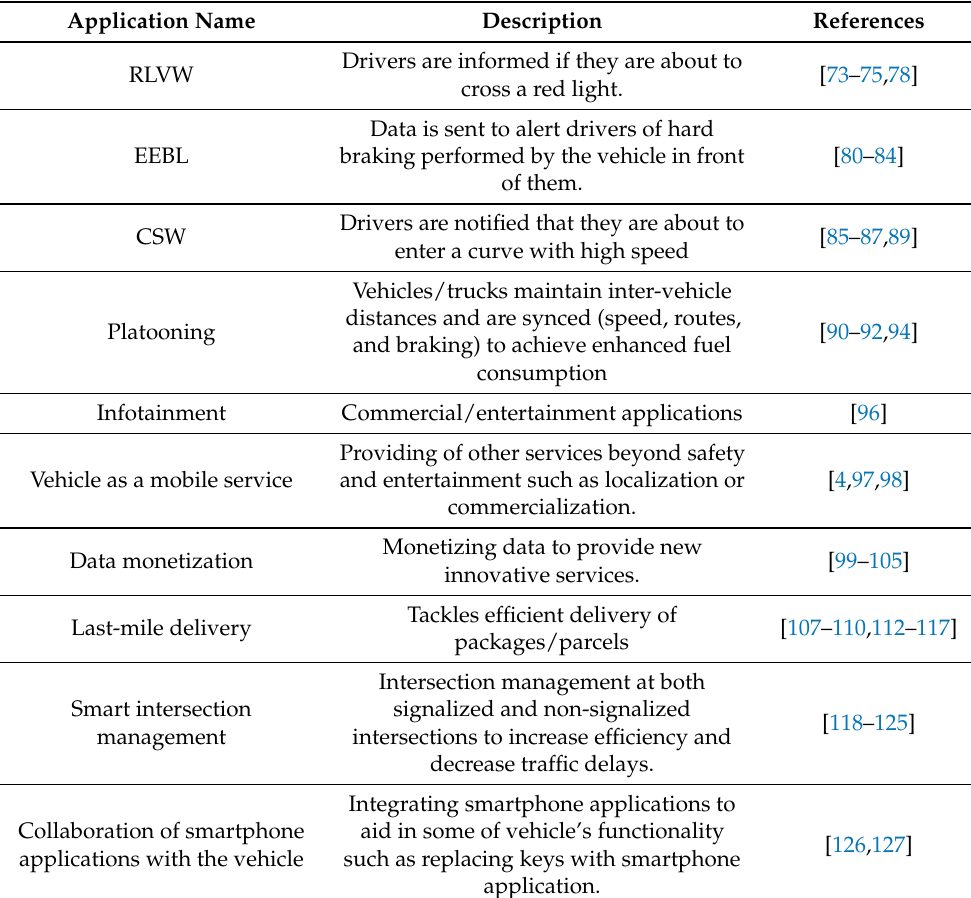
Table 2. Examples of Potential CVs